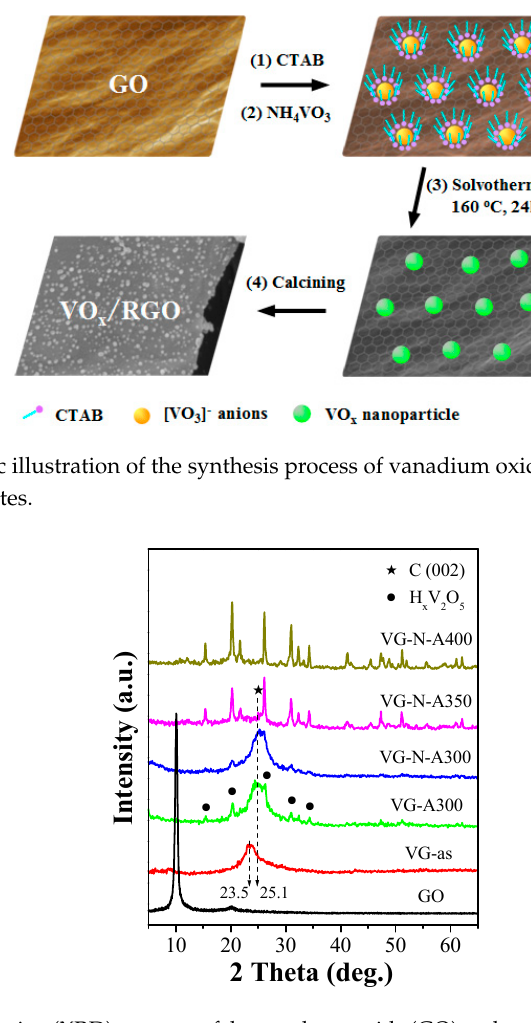
Figure1. X-raydi ff raction(XRD)patternsofthegrapheneoxide(GO)andvariousVO x / Figure 1. X ‐ ray diffraction (XRD) patterns of the graphene oxide (GO) and various VO x /RGO composites.